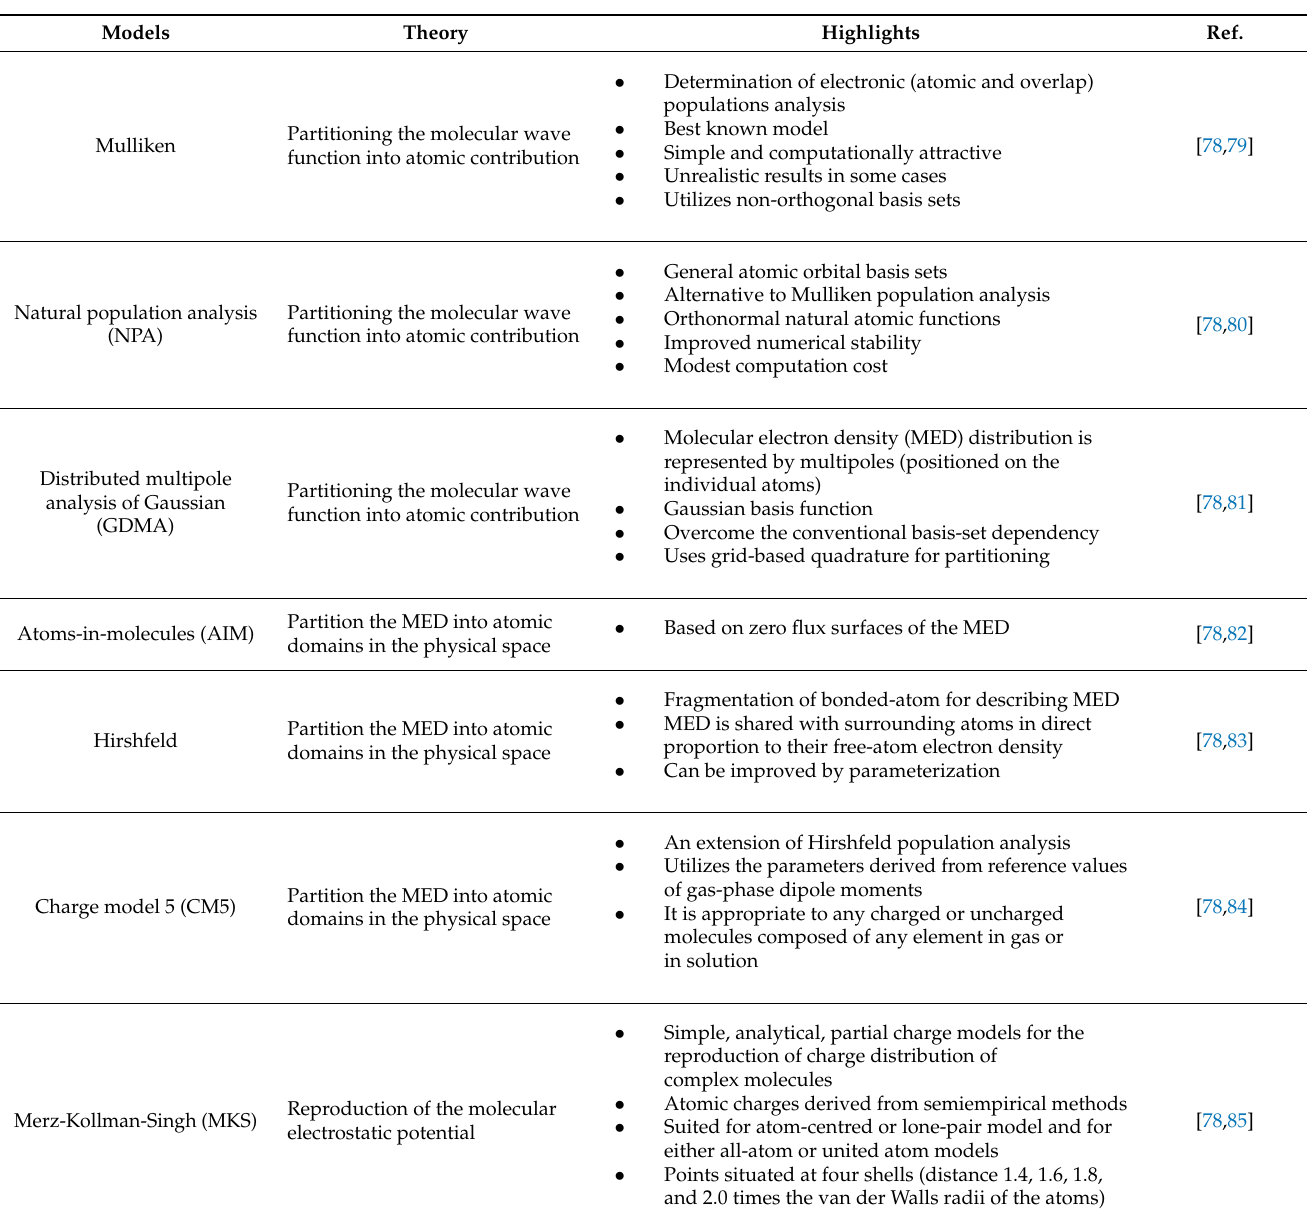
Table 8. The popular models for